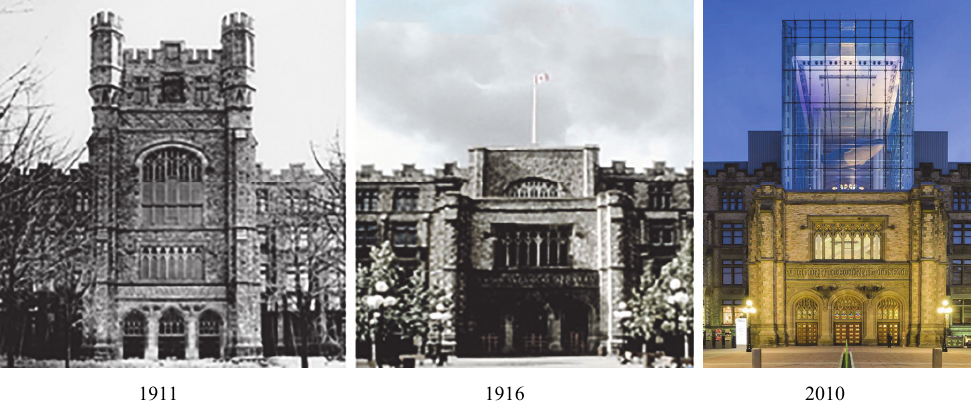
Fig. 9 The original tower of the Victoria Memorial Museum had to be removed due to unstable soil conditions and its massive weight and was replaced by a glass lantern after the rehabilitation of the monument into the Canadian